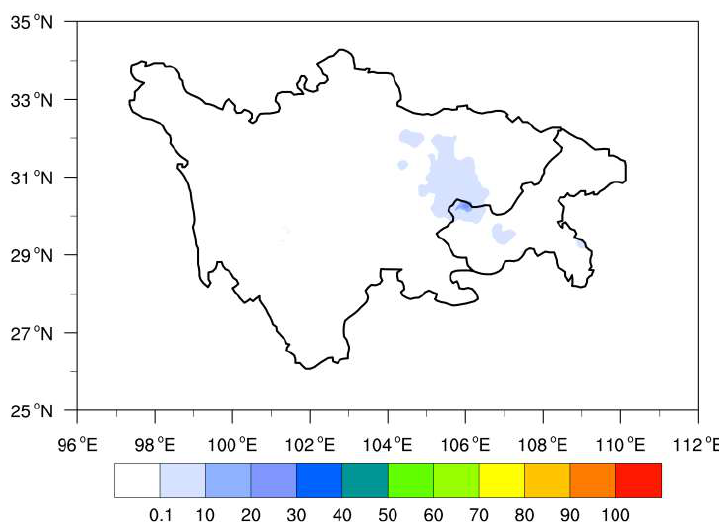
Figure A1. Hourly cumulative precipitation (2300 UTC 1 May to 0000 UTC 2 Figure 1. Hourly cumulative precipitation (2300 UTC 1 May to 0000 UTC 2 May).